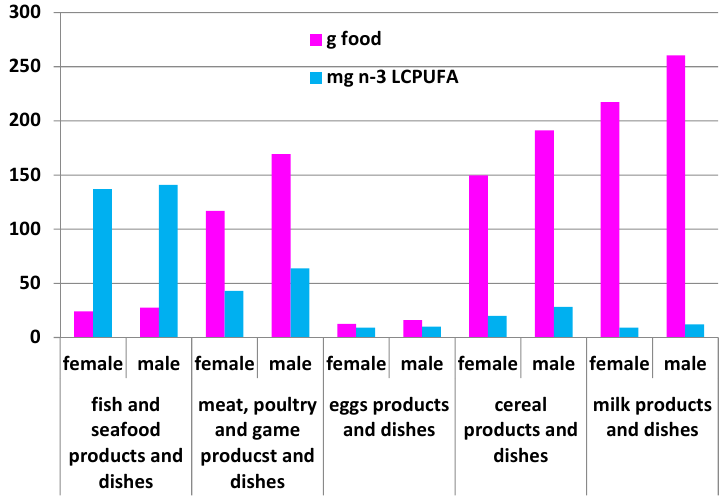
Figure 3. Comparison of the amount of food eaten (g per day) by adult Australians and the respective amount of n ‐ 3 LCPUFA intakes (mg per day) for five main food groups. Fish and seafood: fish, fish and chips, prawns, canned tuna, fish with pasta, paella with seafood; meat, poultry, and game: beef patty, steak, rabbit, offal, ham, lamb casserole, chicken stir ‐ fry; egg products and dishes: eggs, omelette with cheese, spinach soufflé; cereal products and dishes: biscuits, cakes, pies (including meat pies), fried rice, pizza, vol ‐ au ‐ vents , quiche, gnocchi, lasagne, commercial hamburgers, croissants, pancakes; milk products and dishes: milk, yogurt, cream, cheese, ice cream, custard, milkshakes.